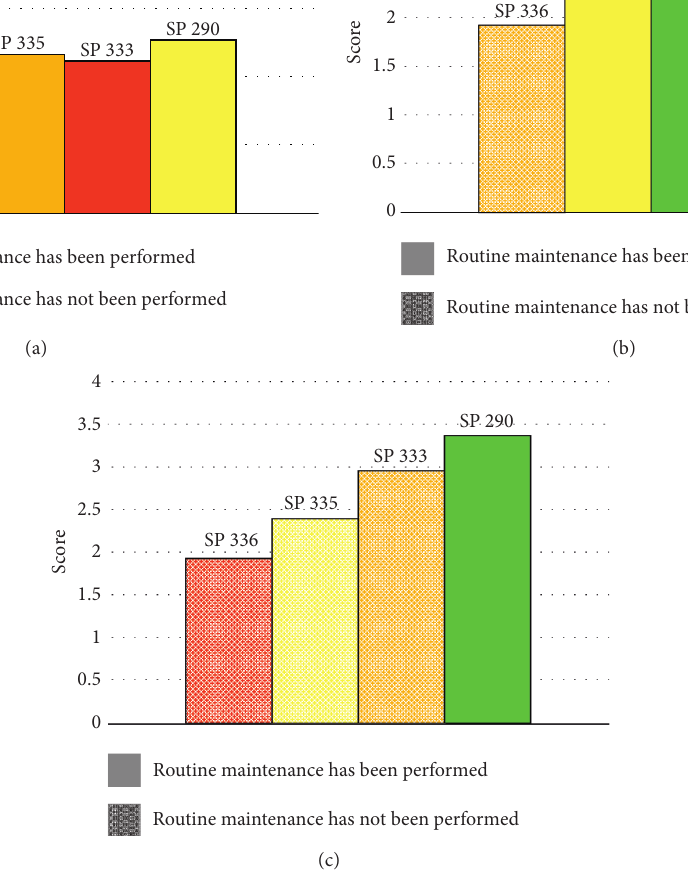
Figure 16: Overall score of the road section pavement condition. (a) Year 2011. (b) Year 2012. (c) Year 2013.